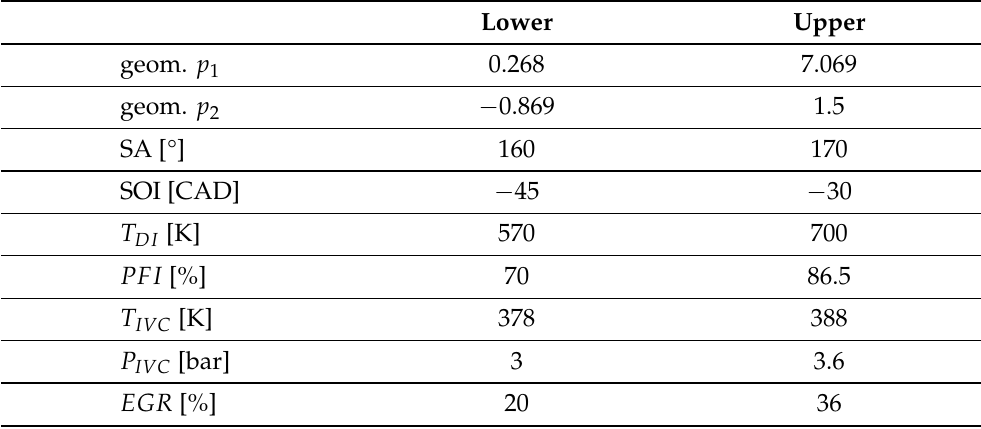
Table 5. Boundaries for each